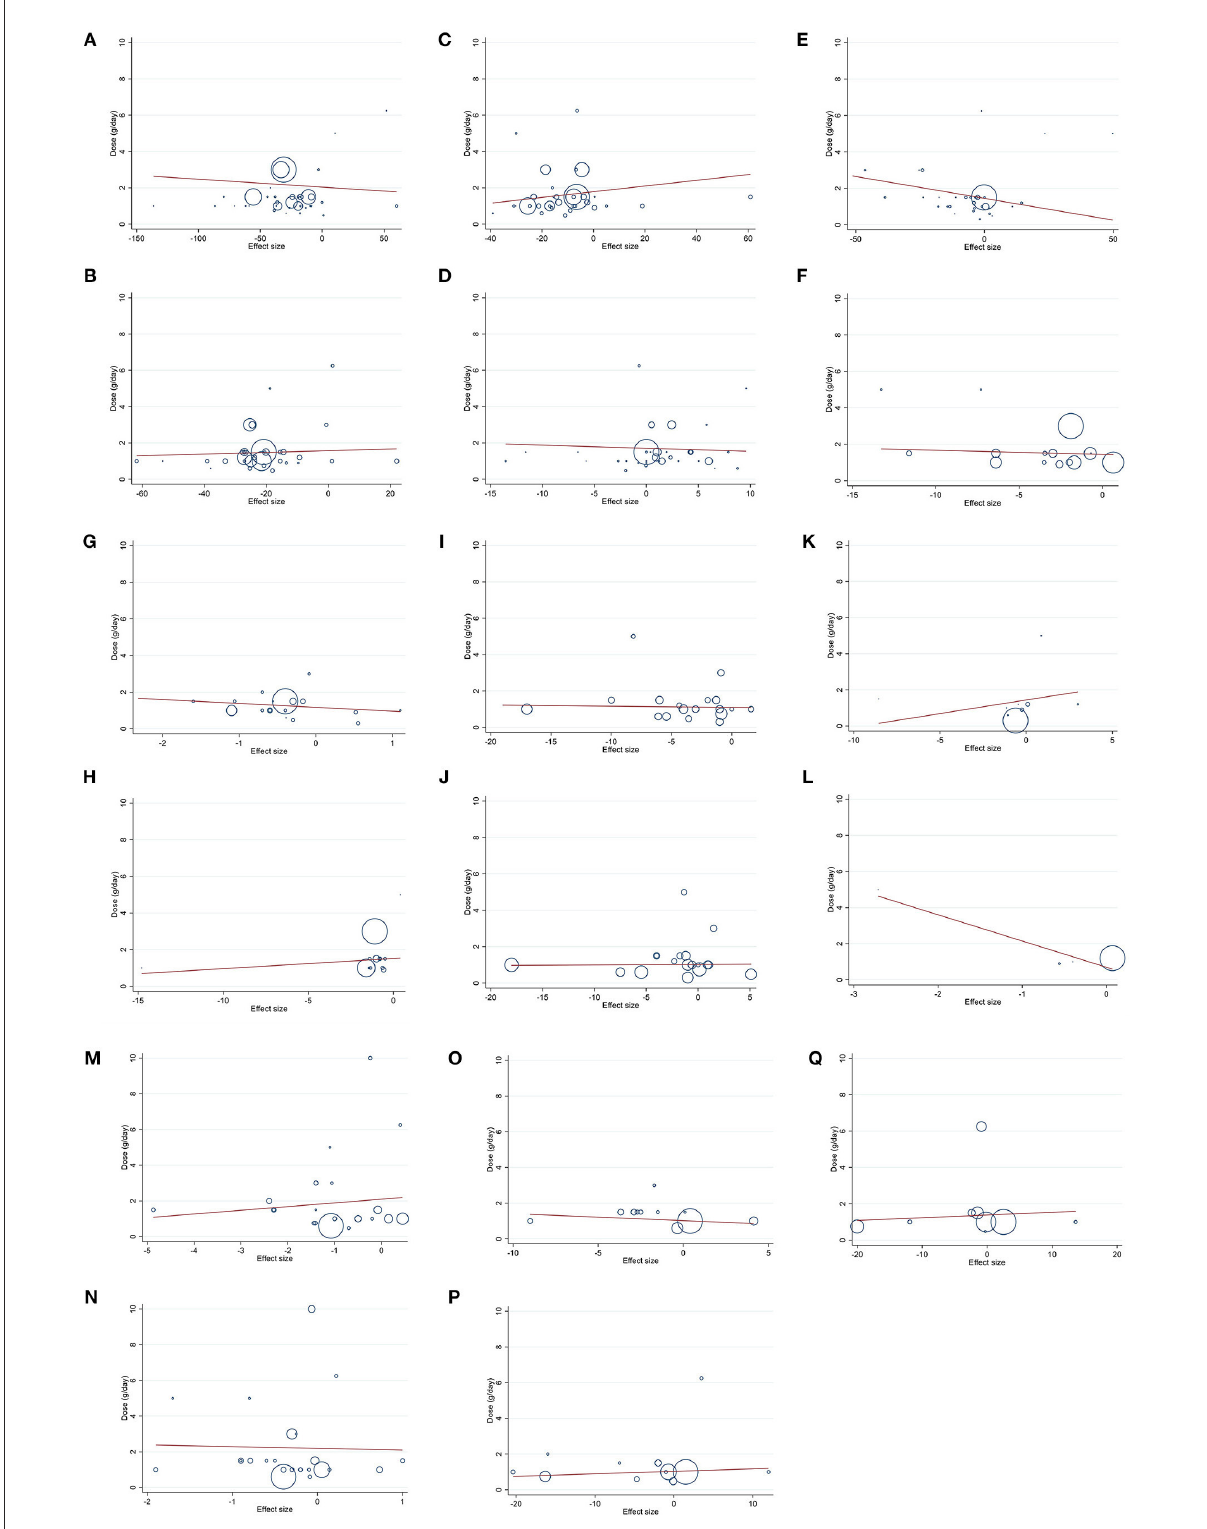
FIGURE4 Linear dose-response relations between berberine consumption and absolute mean differences. Dose-response relations between dose (g/day) and absolute mean differences in (A) TG (mg/dl); (B) TC (mg/dl); (C) LDL (mg/dl); (D) HDL (mg/dl); (E) FBG (mg/dl); (F) Insulin (mg/dl); (G) HbA1c (%); (H) HOMA-IR; (I) SBP (mmHg); (J) DBP (mmHg); (K) CRP (mg/L); (L) IL-6 (ng/L); (M) weight (kg); (N) BMI (kg/m 2 ); (O) WC (cm); (P) ALT (U/L); and (Q) AST (U/L). TG, triglyceride; TC, total cholesterol; LDL, low-density lipoprotein; HDL, high-density lipoprotein; FBG, fasting blood glucose; HOMA-IR, homeostasis model assessment for insulin resistance; hemoglobin A1c, HbA1c; CRP, C-reactive protein; IL-6, interleukin 6; WC, waist circumference; ALT, alanine transaminase; AST, aspartate transaminase; SBP, systolic blood pressure; DBP, diastolic blood